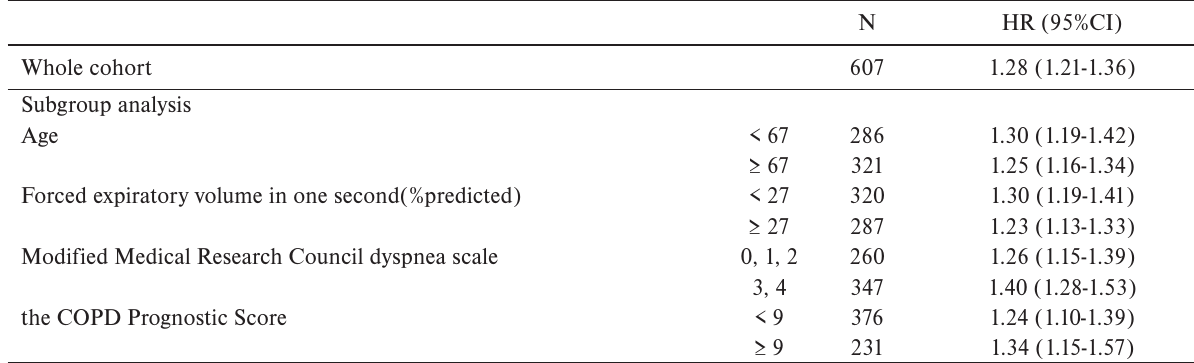
Table 5. Hazard ratio (HR) for all-cause death by one point increase of the COPD Prognostic